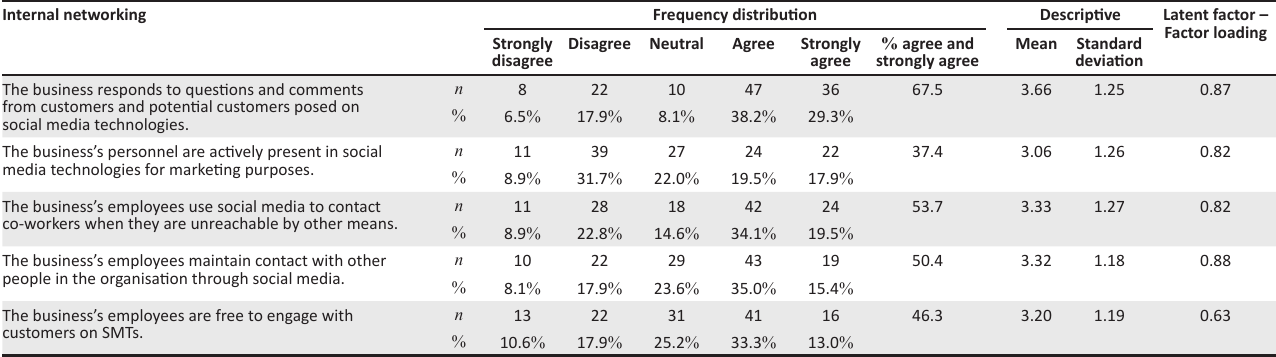
TABLE 5: Internal networking. Internal networking Frequency distribution